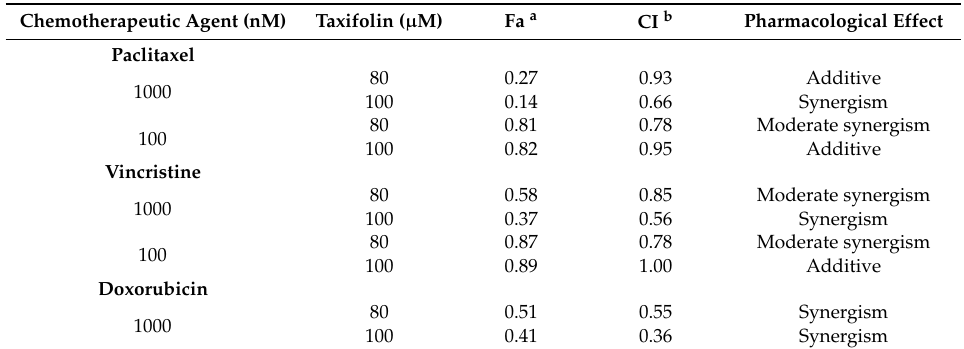
Table 2. Combination index analysis of vincristine, doxorubicin and paclitaxel combined with teaxifolin at a non-constant ratio in MDR KB-vin cells.